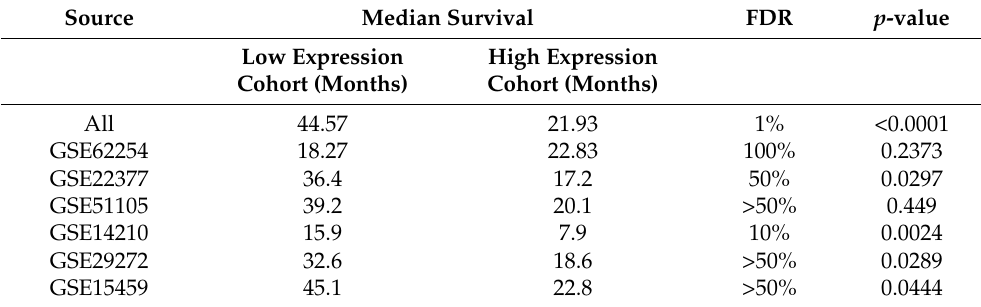
Table 3. CAST RNA expression (according to sequencing) and survival analysis in GC